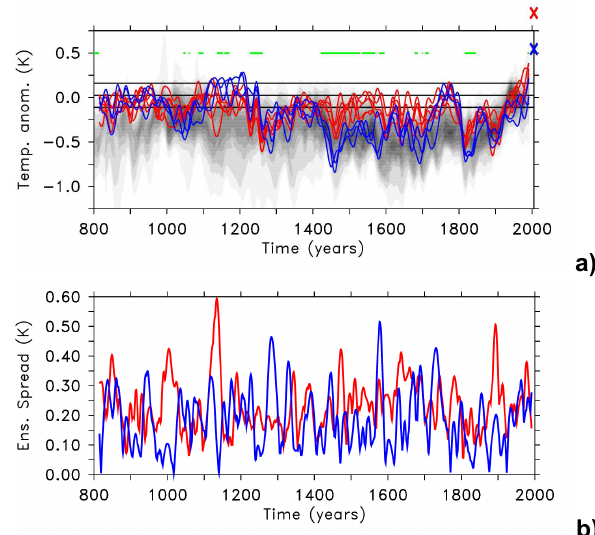
Fig. 3. Evolution of simulated temperature over the last 1200 years: (a) Northern Hemisphere 2m land temperature anomalies w.r.t. the 1961–1990 mean for ensembles E1 (red) and E2 (blue) in compar- ison with the range of reconstructions (gray scale, redrawn from Jansen et al., 2007, see Appendix A). Black horizontal lines indi- cate the control experiment mean and its 5th–95th percentile range. Green horizontal bars indicate periods where the ensembles do not overlap with each other. Time series are smoothed by a 31-yr run- ning mean. Crosses at the right axis denote the ensemble means (annual average) at the end of the simulation (2005), (b) ensemble spread for the ensembles E1 (red), and E2